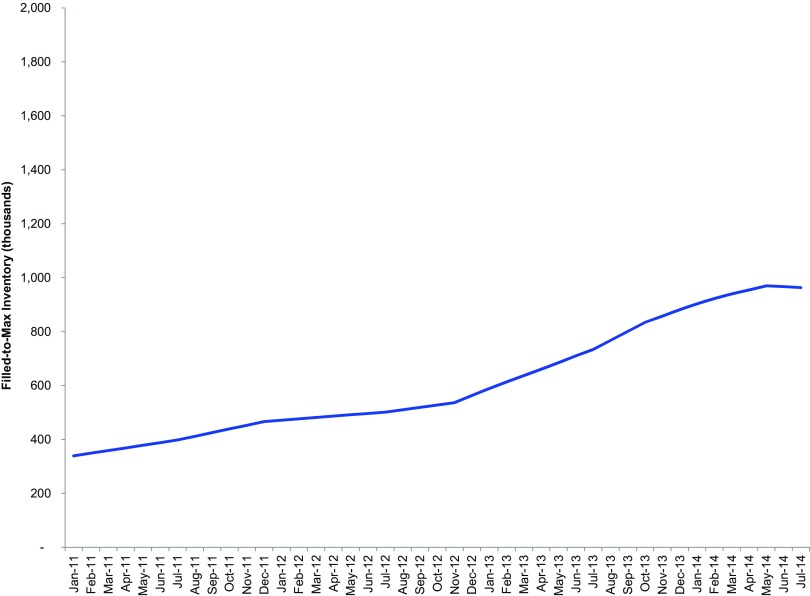
Calculated Filled to Max Inventory, Ethiopia Model as an Example